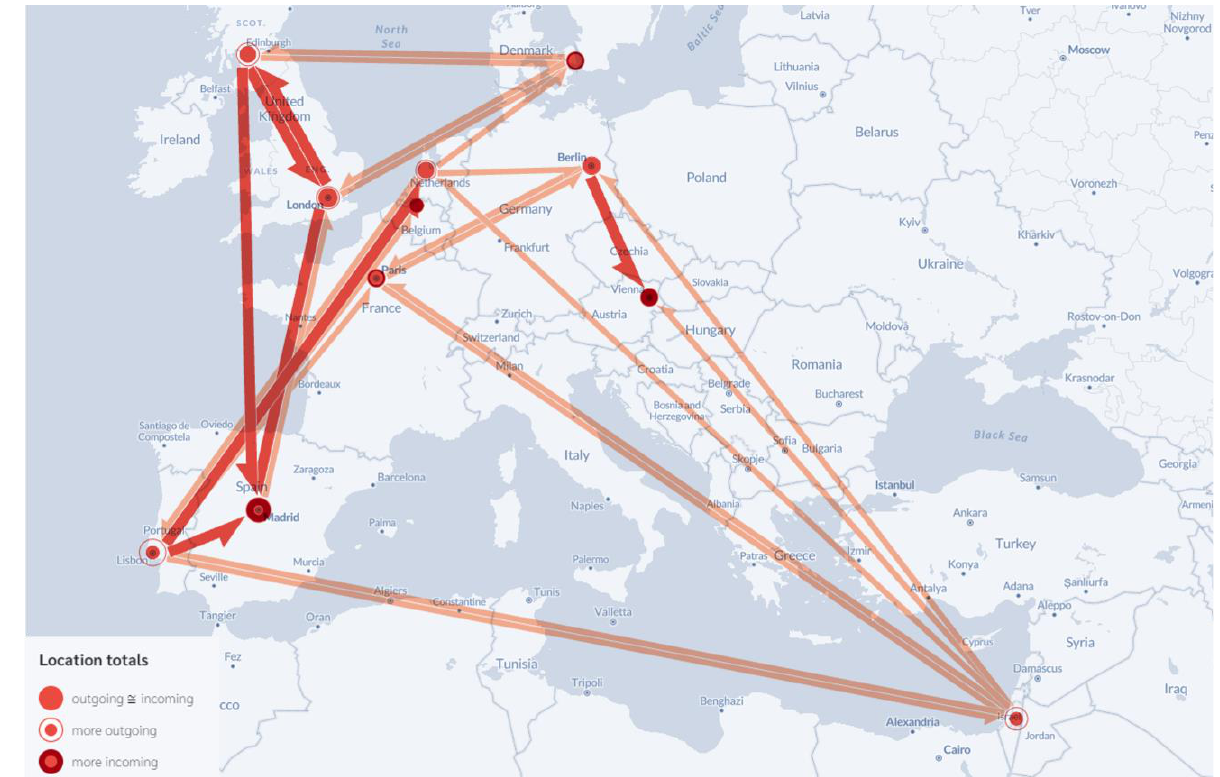
Figure 2. Significant early dispersal pathways of SARS-CoV-2 BA.5 subvariant across Europe. The color and classification of countries are as described in Figure 1. Flow map was created by using FlowmapBlue tool.